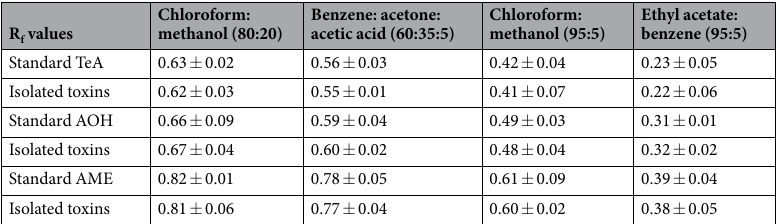
Table 3. Comparisons of R f value of the phytotoxins isolated from Alternaria species with standards of tenuazonic acid, alternariol, alternariol monomethyl ether by TLC Note: R f value is the ratio of the distance travelled by the substance and the distance travelled by the solvent (The spots were developed by spraying the plates with 0.2% FeCl 3 in ethanol and some are detected in UV-light at 365